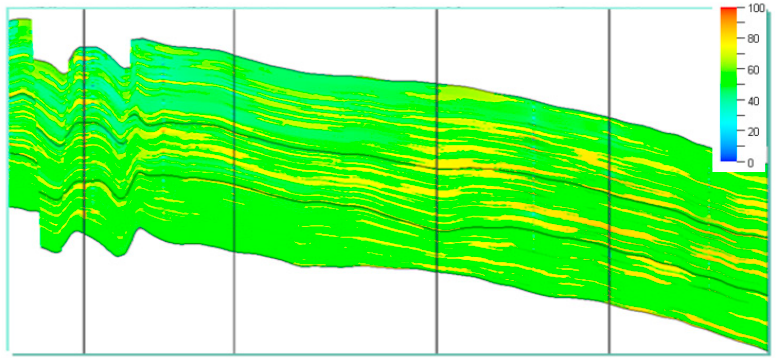
Figure 10. Cross-section map of the brittleness index in the N–S direction.